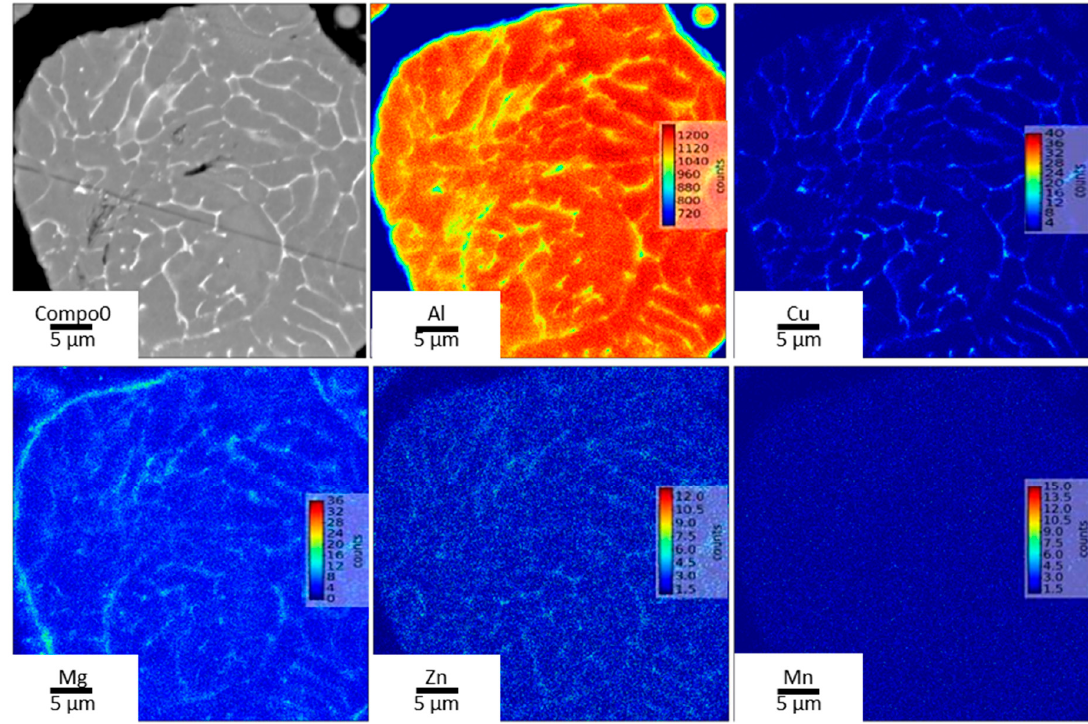
Figure 2. Electron Probe Micro Analyser (EPMA) maps of a cross-sectioned powder particle showing inter-dendritic phase with high Cu enrichments and significant concentrations of Zn and Mg.